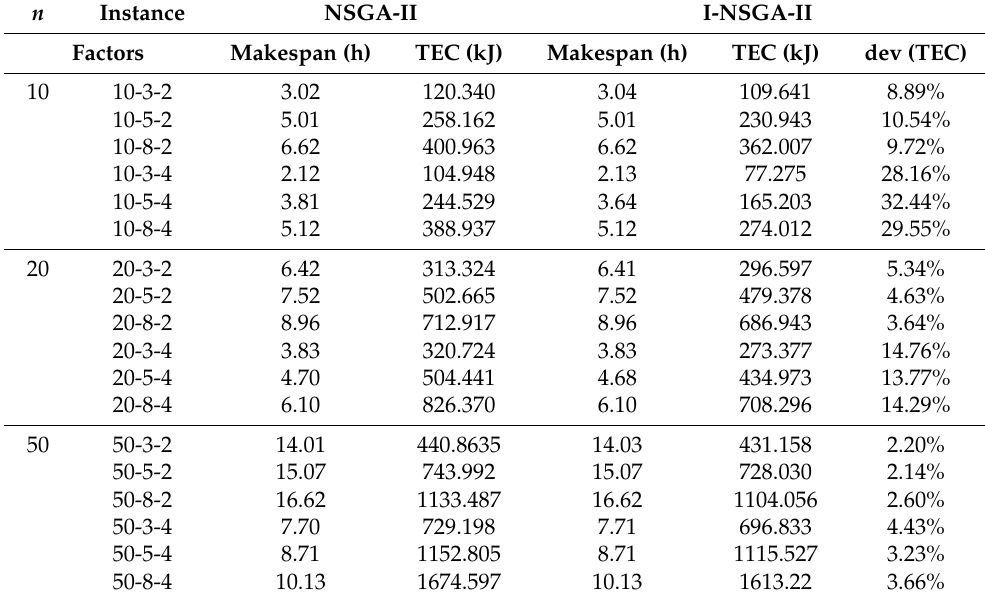
Table 7. Comparisons of algorithmic AVG